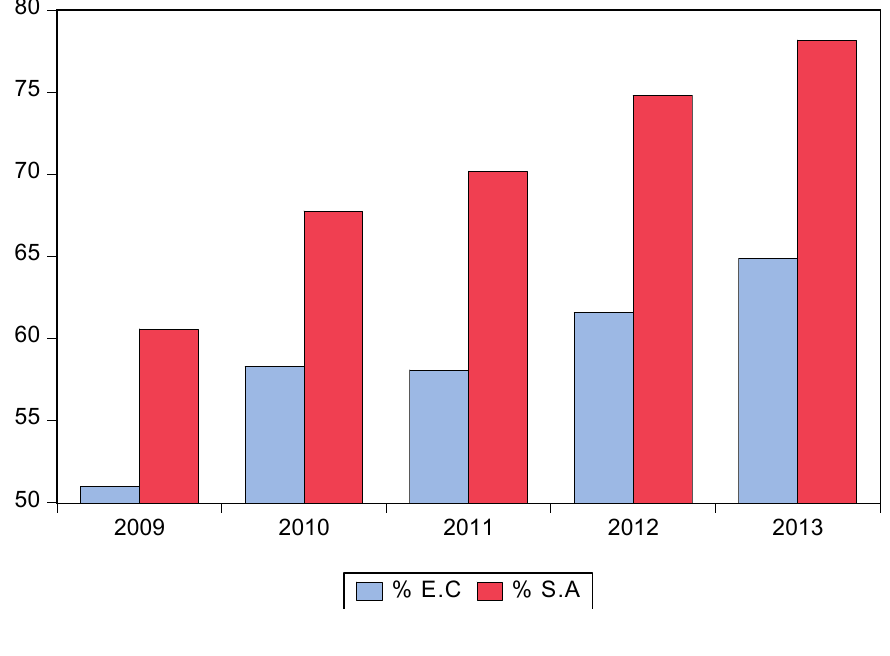
Figure 2: Percentage pass of South Africa and Eastern